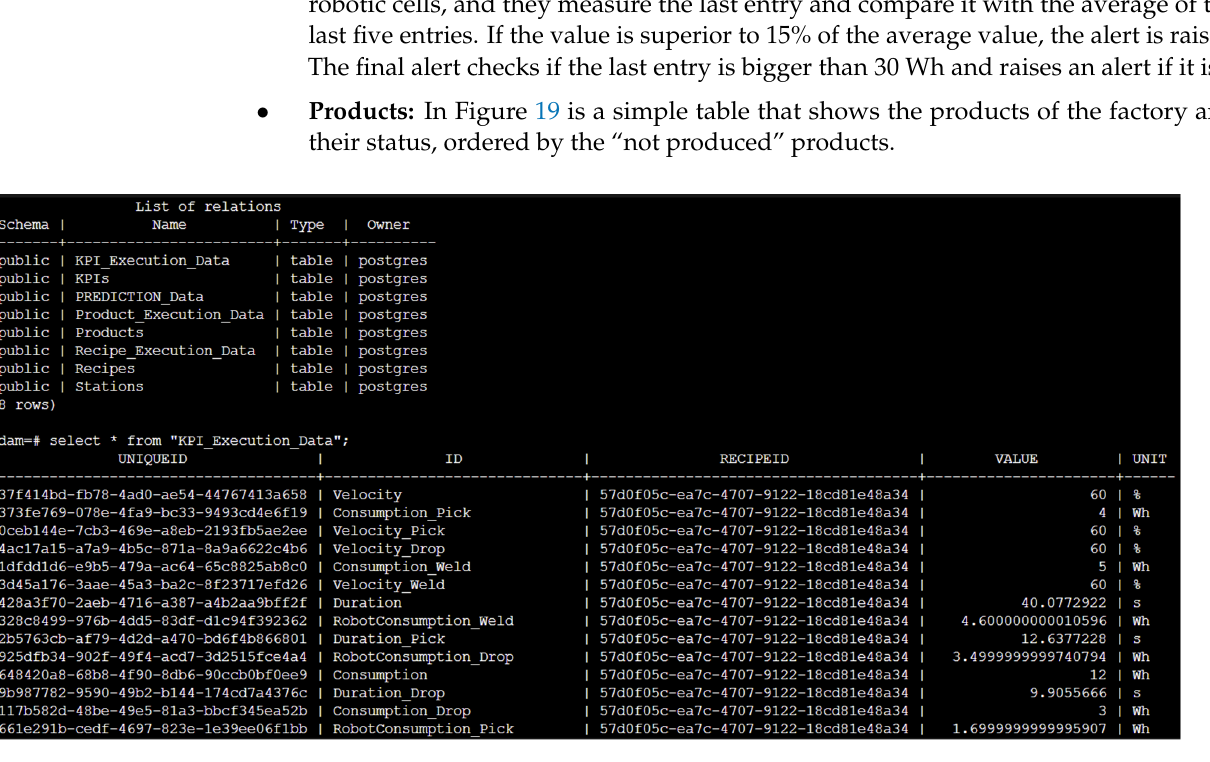
Figure 17. Database visualization.